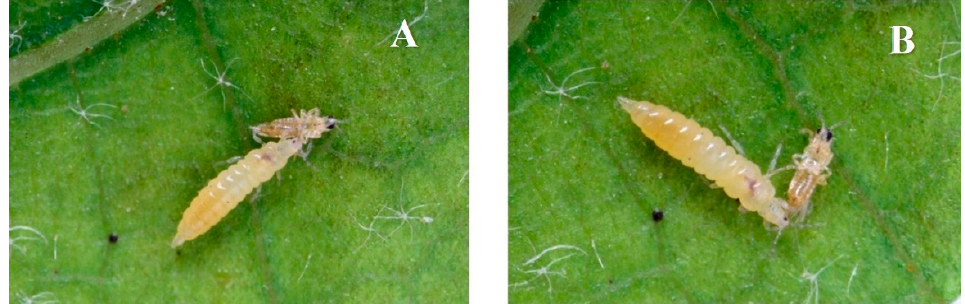
Figure 5. Predation of an Aeolothrips intermedius larva on an onion thrips Thrips tabaci adult. ( A ) start of the predation (the predator captures and subdues the prey); ( B ) end of the predation (the predator stops feeding on the prey).